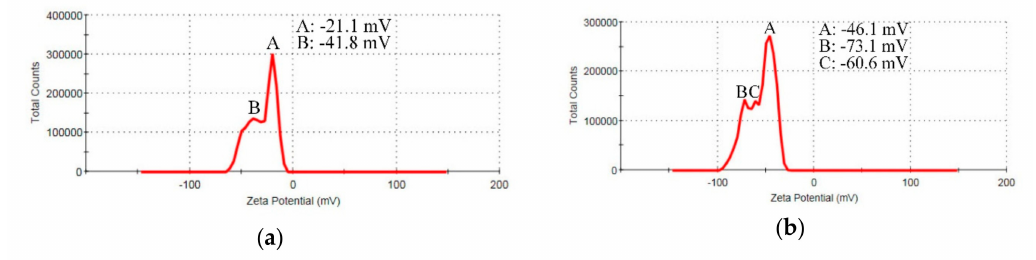
Figure 4. Zeta potential of ( a ) GO; ( b ) rGOAg.